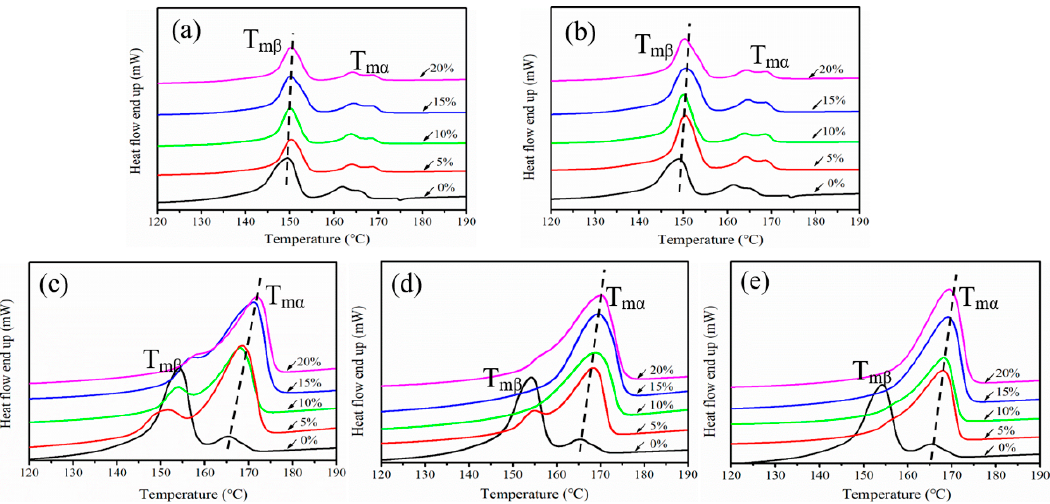
Figure 3. The melting curves of the iPP sheet after stretching at different temperatures: ( a ) 110 °C, ( b ) 120 °C, ( c ) 130 °C, ( d ) 140 °C, and ( e ) 150 °C.